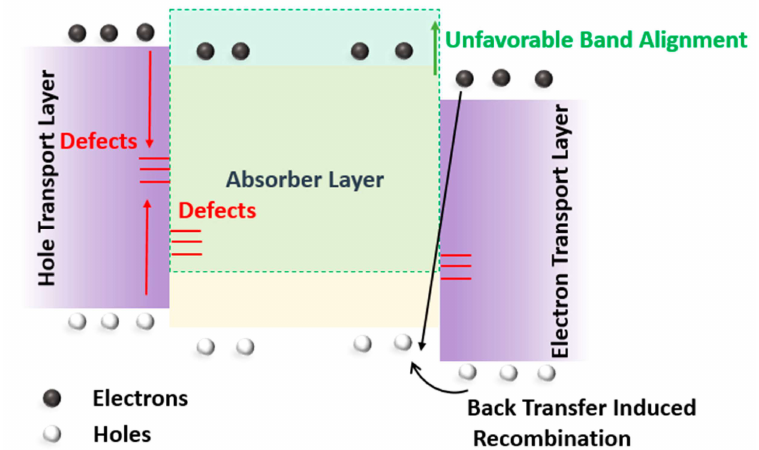
Figure 9. Illustration of interface defects mechanism in a solar cell.